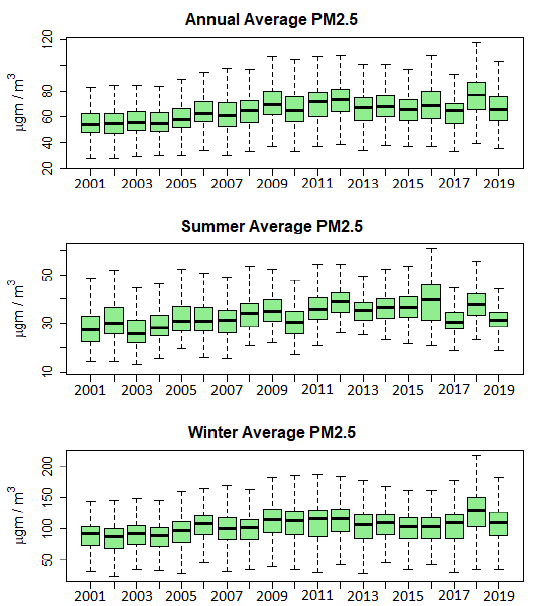
Figure 4 . Temporal variability of annual, winter and summer PM 2.5 during 2001–2019.